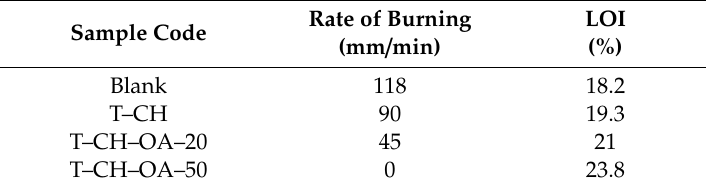
Table 3. Flammability data for uncoated and coated samples.